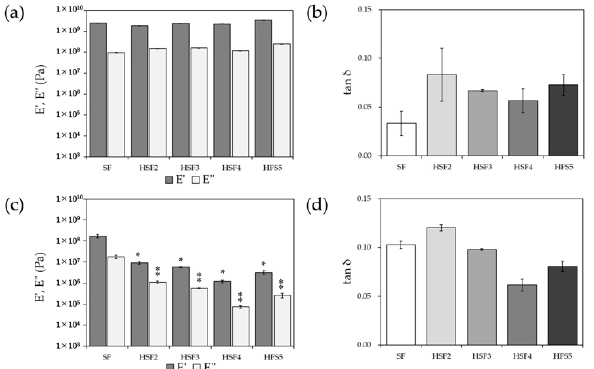
Figure 6. The storage elastic modulus (E ′ ) and loss elastic modulus (E ″ ) ( a , c ), and the loss factor (tan δ ) ( b , d ) of SF and heparin-modified samples. ( a , b ) dry state and ( c , d ) wet state (* , ⁑ p < 0.05 relative to each SF).